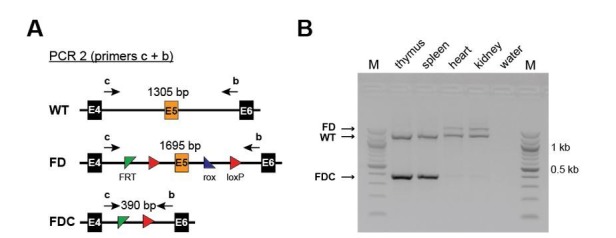
Efficient recombination occurs only in hematopoietic and not in non-hematopoietic organs of Setd1b FD/+;Vav-Cre/+ mice.(A) PCR strategy to detect the WT, the unrecombined FD and the recombined FDC allele using primers upstream of the 5’ FRT site and downstream of the 3’ loxP site. (B) Efficient recombination as defined by the presence of the FDC band occurs only in thymus and spleen but not in heart and kidney.